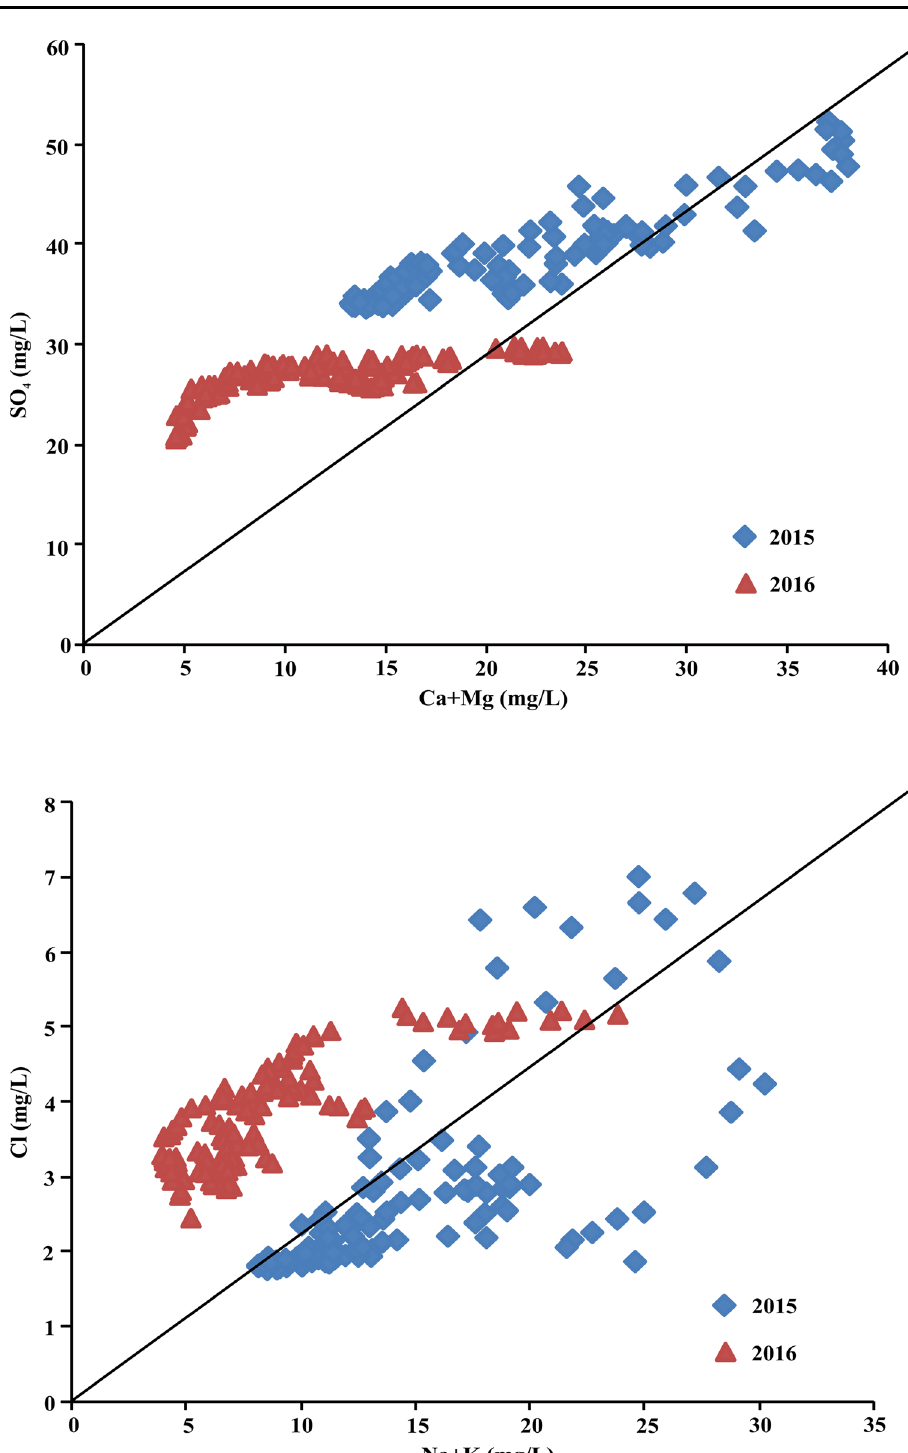
Fig. 7 Scatter plot between (Ca + Mg) and SO 4 to determine the supply of sulphate in the meltwater